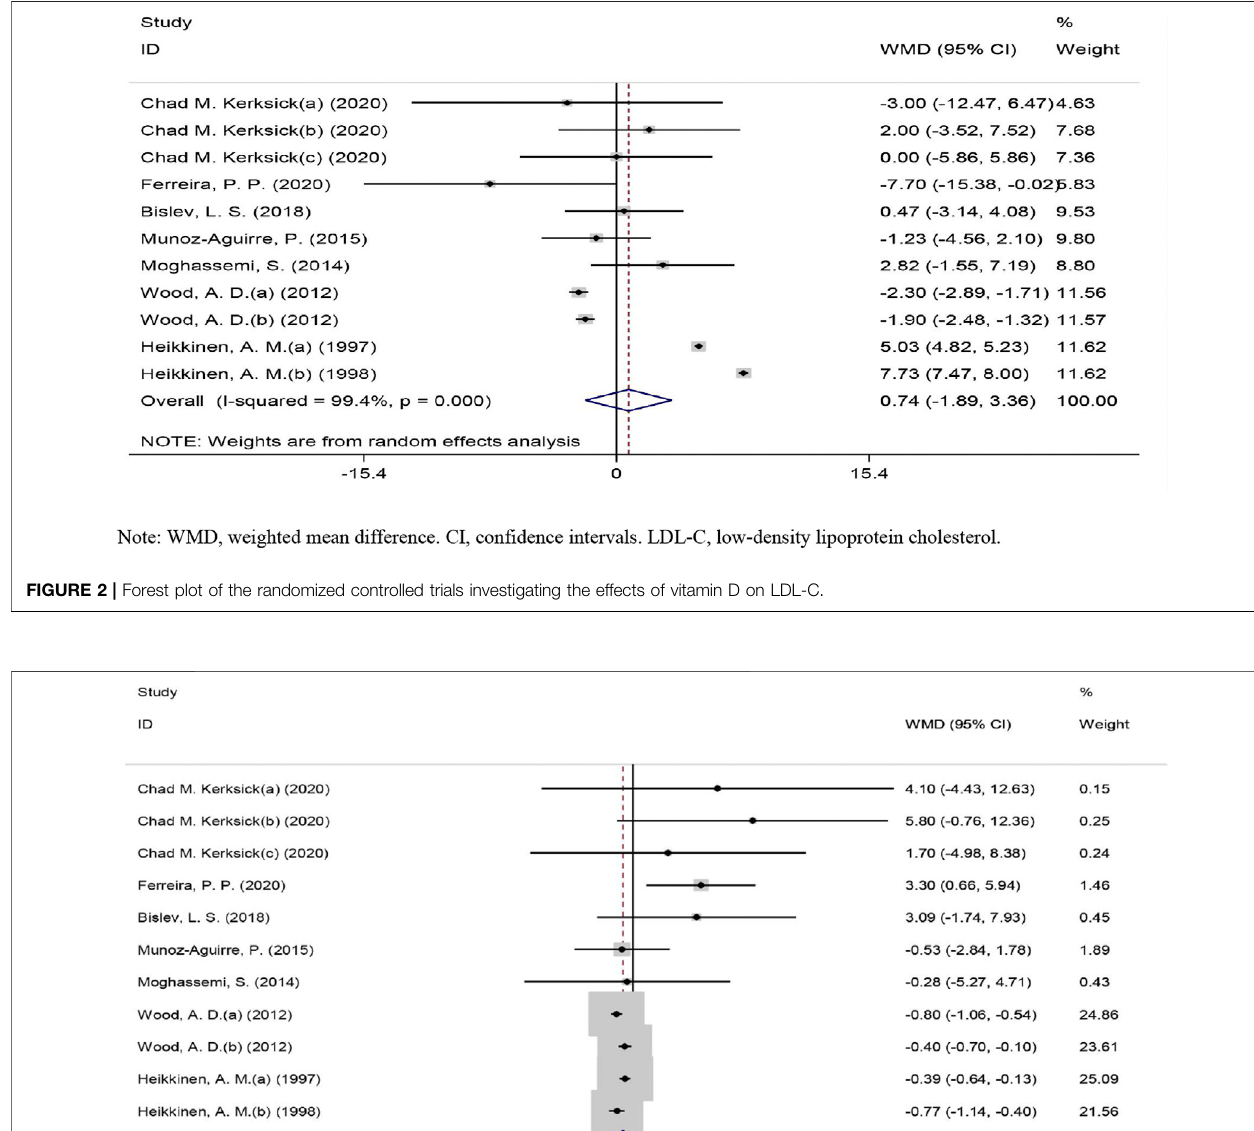
The overall effect of vitamin D intervention on TG level from 11 eligible trials (placebo (cid:1) 505 participants, vitamin D intervention (cid:1) 604 participants) are reported in Figure 4 .